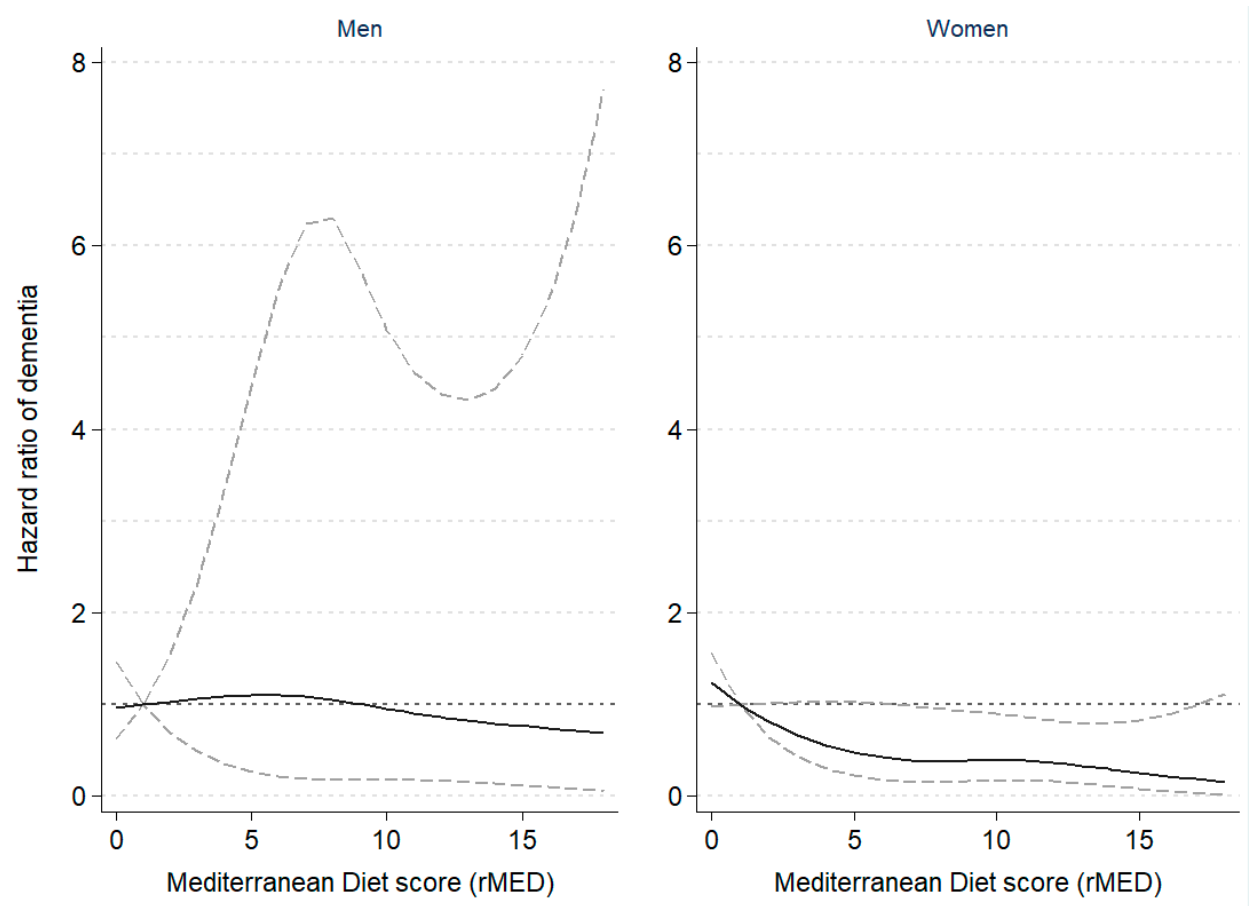
Figure 1. Hazard ratio of dementia according to Mediterranean Diet scores in the EPIC-Spain Dementia Cohort study ( N = 16,160), by sex. The dashed lines represent the upper and lower 95% confidence interval limits of the estimates. A non-linear inverse association between risk of dementia and rMED scores was observed among women, but not among men. Hazard ratios of dementia were estimated using Cox proportional hazards regression models, with age as the time scale, stratified by center and age (in 5-year categories), and adjusted by sex, education, energy intake, smoking, BMI category, elevated waist circumference, household and recreational physical activities, hypertension (self-reported), hyperlipidemia (self-reported), coffee and tea consumption (combined), and intake (in g/day per 2000 kcal) of potatoes, eggs, and cakes and biscuits. In women, models were further adjusted by menopausal status, oral contraceptive use, and hormone replacement therapy. Dementia risk was modelled following a restricted cubic spline transformation of the rMED variable with three degrees of freedom (knots were placed at the 33rd and 67th percentiles).